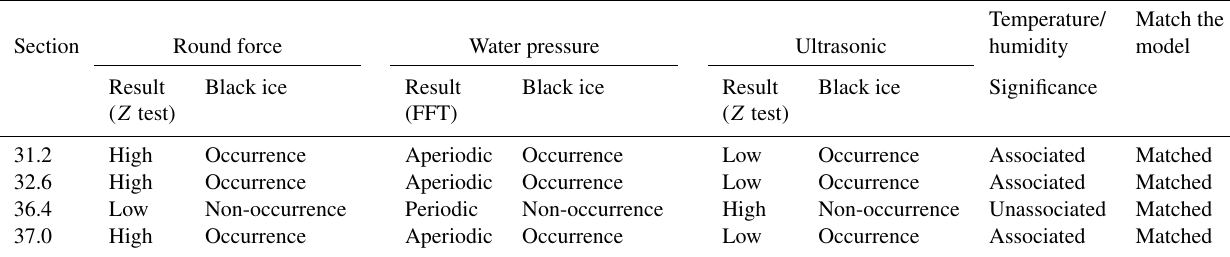
Table 8. Comprehensive analysis result of multi-sensor.